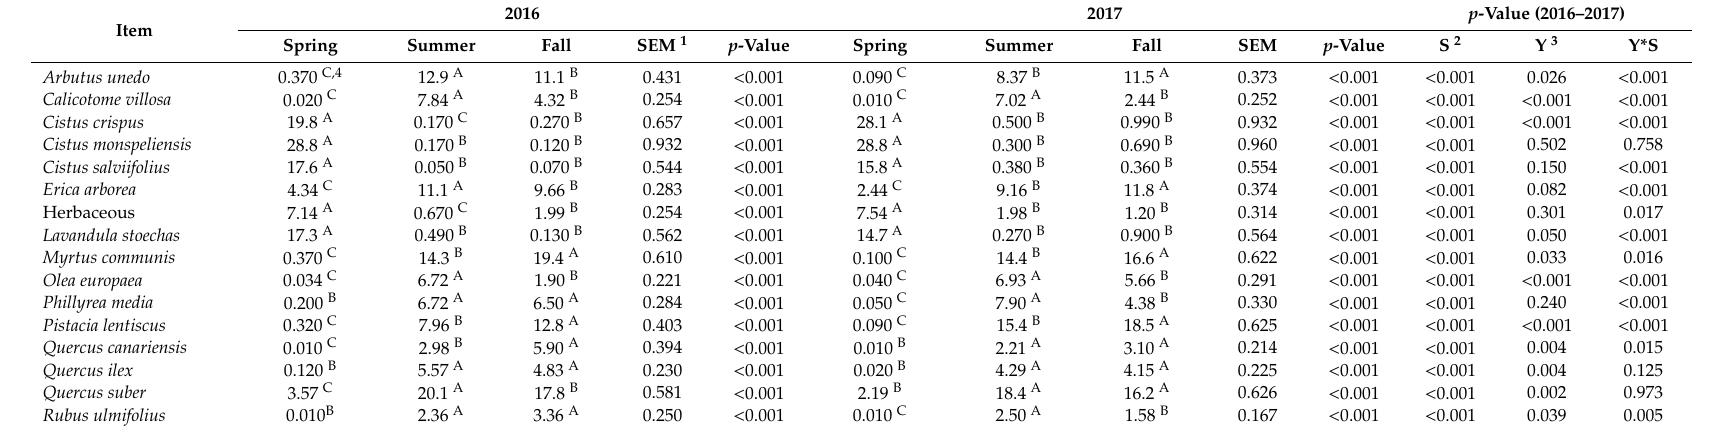
Table 3. Diet composition (% of DM) of goats browsing a Southern Mediterranean forest rangeland during 2016 and 2017.